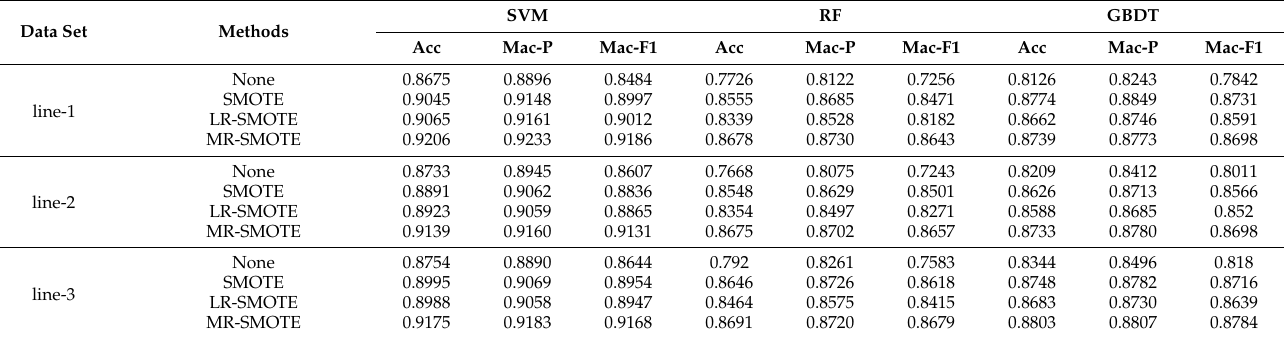
Table 6. Experimental results of the linear unbalanced data set.